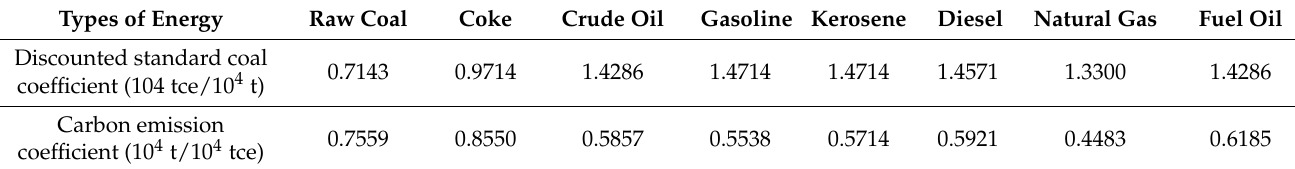
Table 1. Calculation parameters of carbon emissions for different types of fossil fuel